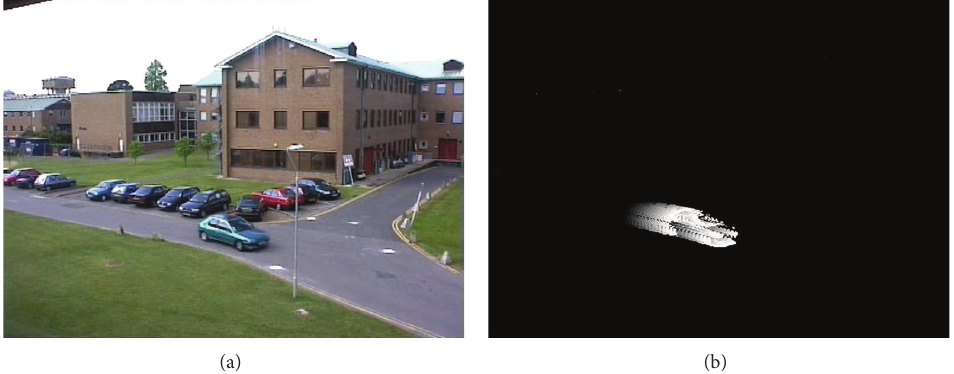
Figure 1: (a) The original image of the car. (b) The tMHI of the car. Here, 𝜎 = 20 and 𝛿 = 10 s.